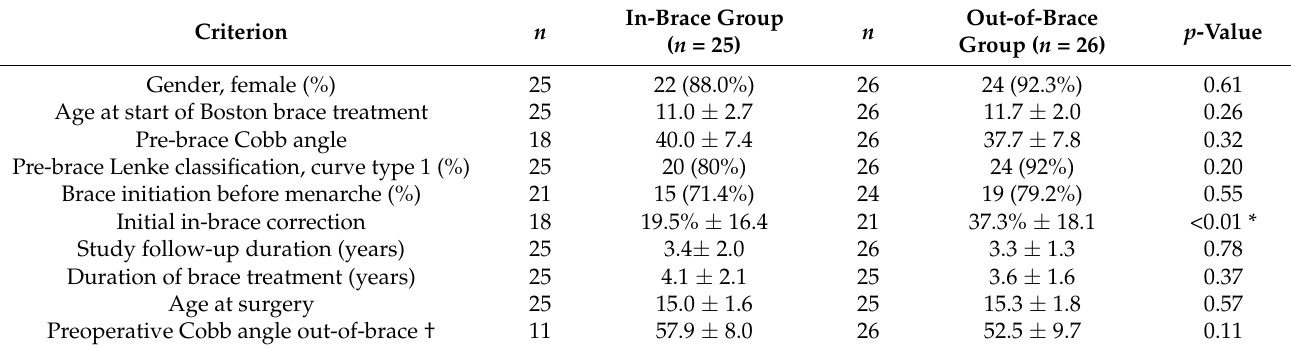
Table 2. Patient